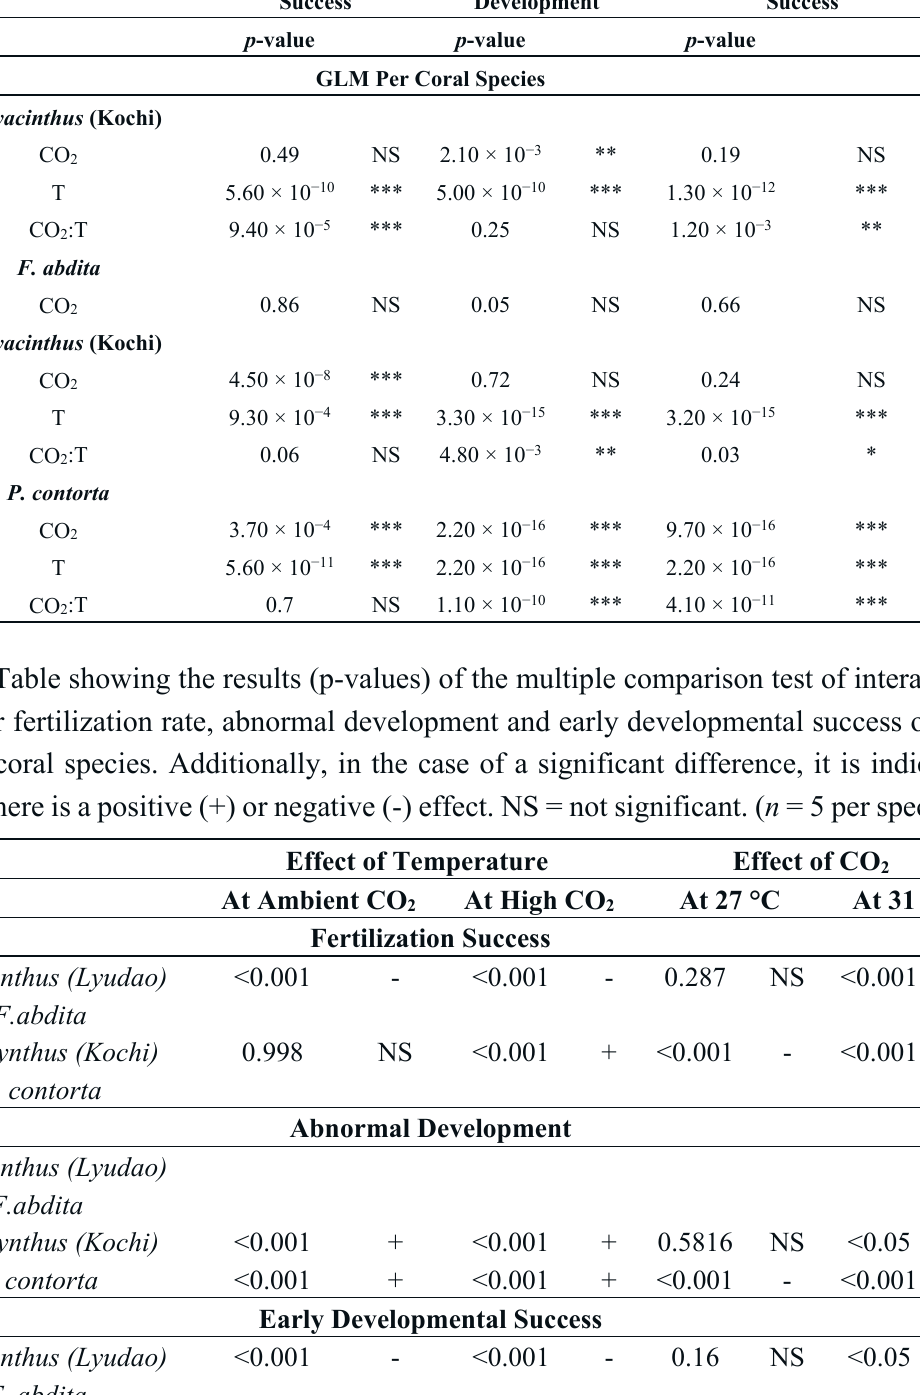
Table 1. Table showing a summary of the results of logistic regression using GLM for fertilization rate, abnormal development and early developmental success of (1) the full model and (2) the different coral species. NS = not significant, * means p < 0.05, ** means <0.01 and *** means <0.001. See Table S2 for the Analysis of Deviance tables. Fertilization Success